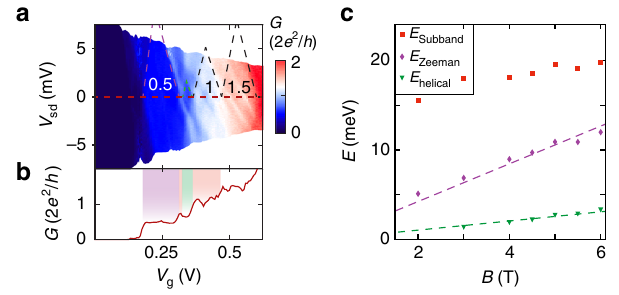
Fig. 3 Voltage bias spectroscopy of the helical gap. a Conductance measurement as a function of QPC gate V g and source-drain bias voltage V sd at B = 4 T. The observed helical gap is a stable feature in voltage bias. Dotted lines are drawn as guide to the eye indicating the linecut presented in b ( red ), as well as the edges of the 0.5 · G 0 plateau ( purple ), helical gap ( green ) and the 1 · G 0 and 1.5 · G 0 plateaus ( black ). b , Linecut of a taken at V sd = 0 mV together with the color scheme explained in Fig. 1. c Evolution of the energy levels extracted from the scans similar to a , at increasing magnetic fi eld. Fits with intercept fi xed at zero ( dotted lines ) give the g -factor of the fi rst subband and the offset angle via g ¼ 1 = μ d E = d B and E helical = E Zeeman (cid:2) tan θ . We fi nd g = 38 ± 1 and θ = 13° ±